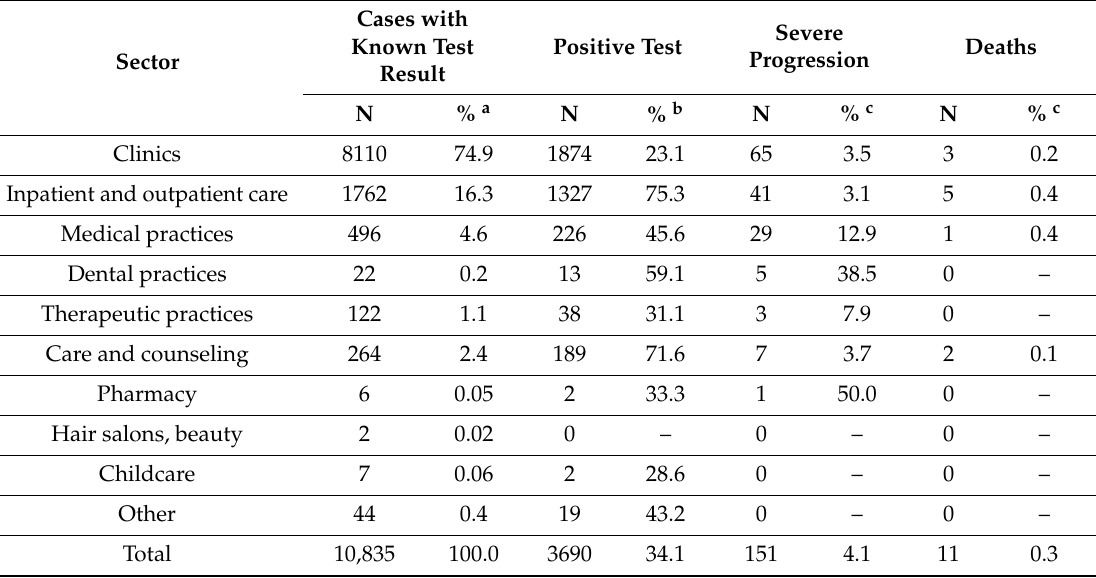
Table 3. COVID-19 cases reported to the accident insurance provider BGW by